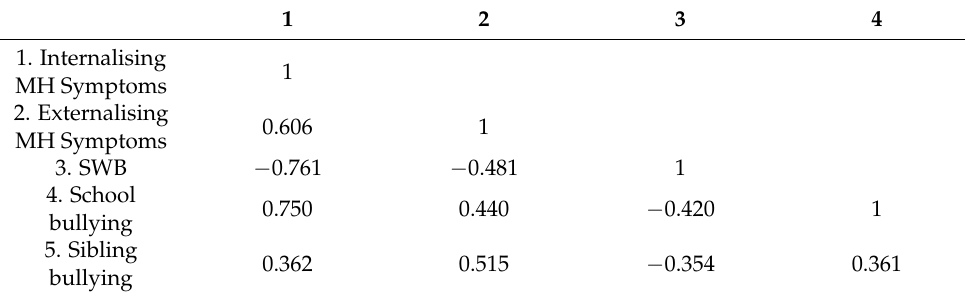
Table 2. Error-free latent correlation